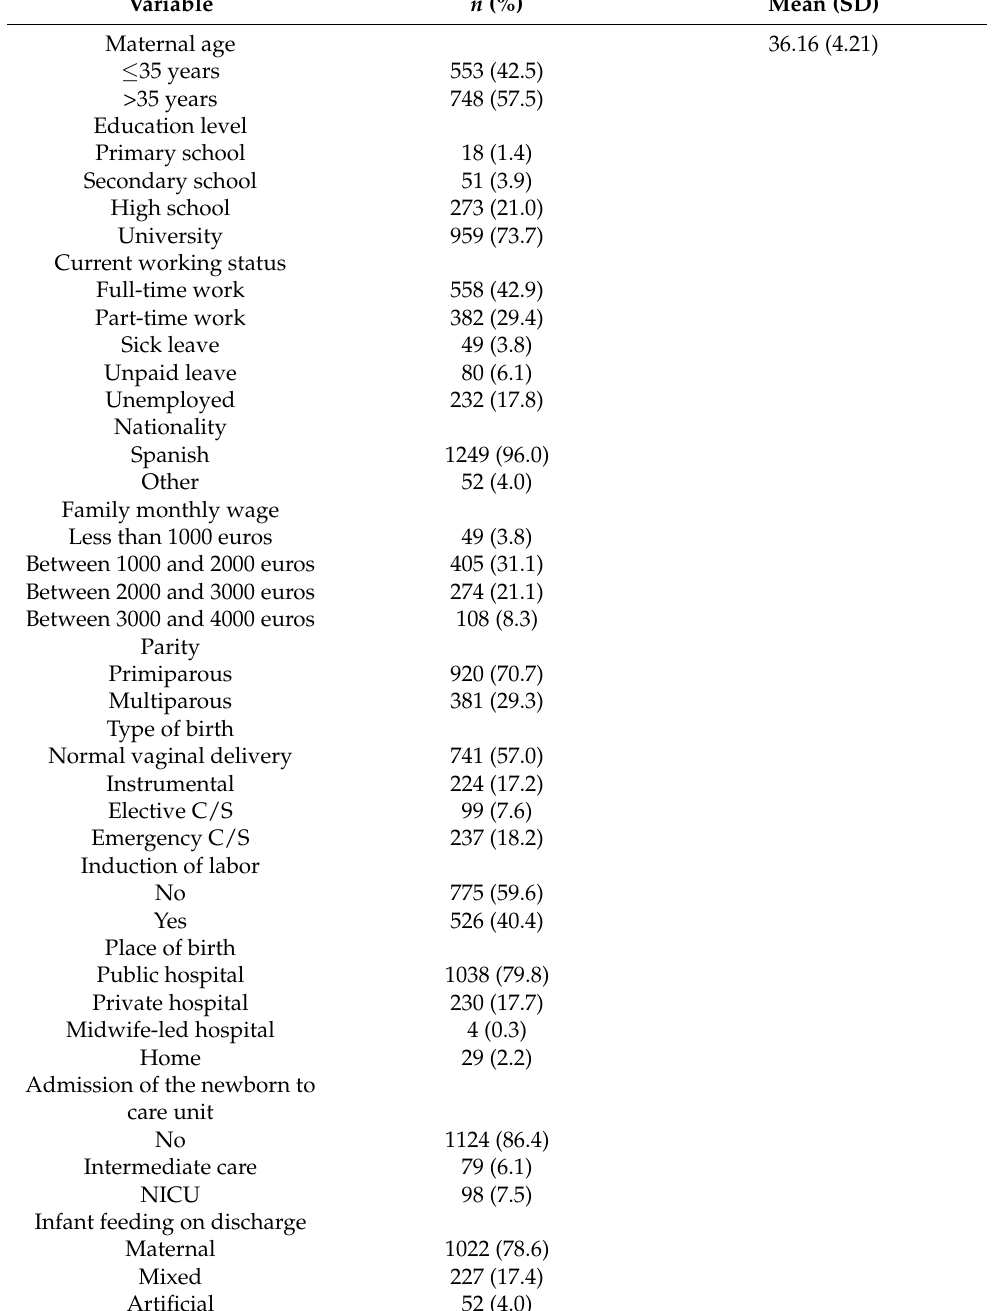
Table 1. Sociodemographic and current pregnancy characteristics of the sample. C/S: cesarean section; NICU: neonatal intensive-care